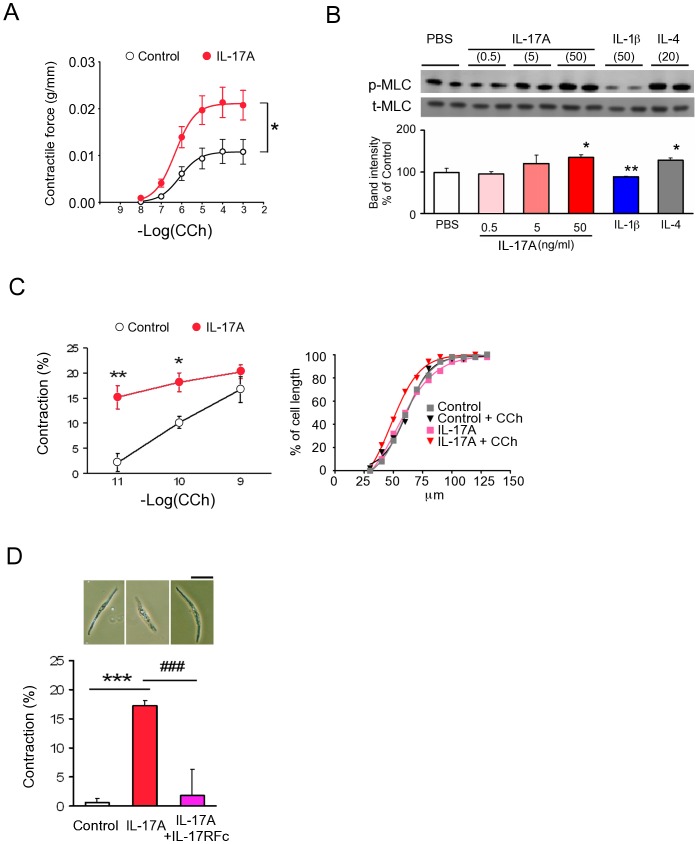
IL-17A induces hypercontractility of SI longitudinal MS and SMCs.(A) CCh-stimulated dose-response curves of MS contractility induced by IL-17A treatment for 3 days. CCh was added cumulatively (n = 9). (B) Immunoblot analysis of phosphorylated Ser19 of myosin light chain 2 (p-MLC) in samples of MS treated with or without IL-17A, IL-1β or IL-4 and quantitation of band intensity (n = 3∼4). The ratio of p-MLC to total MLC was calculated as described in Materials and Methods and normalized to untreated samples. N means the number of mice. Upper panels are representative images. (C) The Left panel shows CCh-stimulated dose-dependent changes of SMC contractility induced by IL-17A treatment for 24 hr. The respective concentration of CCh was added separately (n = 5). The right panel shows the distribution of cell length of 10−11 M CCh-stimulated SMCs with or without IL-17A treatment for 24 hr (n = 4). Y axis represents accumulating percentage of the number of the cells whose length are equal to, or smaller than, the length indicated in the x axis. The graph suggests that almost all of the analyzed SMCs responded to CCh stimulation. (D) Contractile response to CCh of SMCs treated with or without L-17A and/or IL-17R-Fc-Chimera (n = 6∼7). Upper panels are representative phase-contrast images. Scale bar, 50 µm. Numerical data represent means ± s.e.m. *P<0.05, **P<0.01 ***P<0.001 versus control/PBS-treated, ###P<0.001 versus IL-17A-treated. Repeated measure ANOVA (A), Student's t-test (B-D) with the closed testing procedure (B) and Bonferroni correction (D) for multiple comparisons.